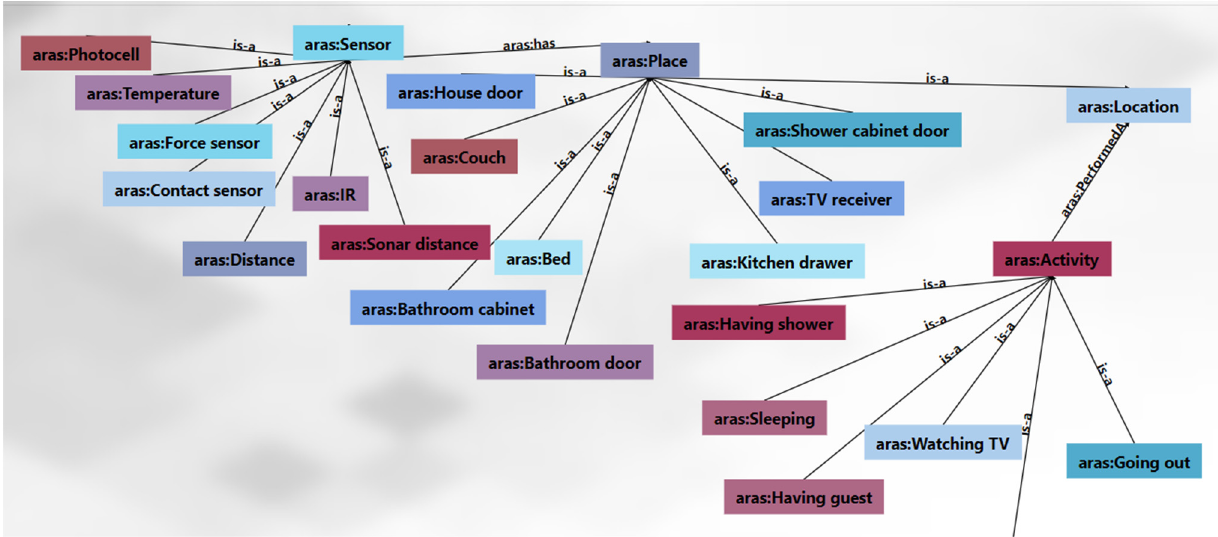
Figure 21. Ontology-based model learning at 𝑡 (cid:2870) in the refinement phase, an excerpt of a partially refined local ontology after non-taxonomic refinements.